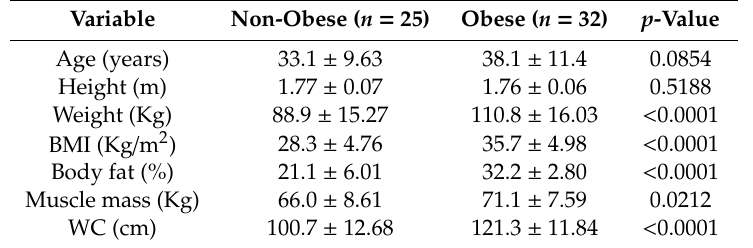
Table 4. Anthropometrics characteristics for the obese and non-obese groups according to body fat percentage.